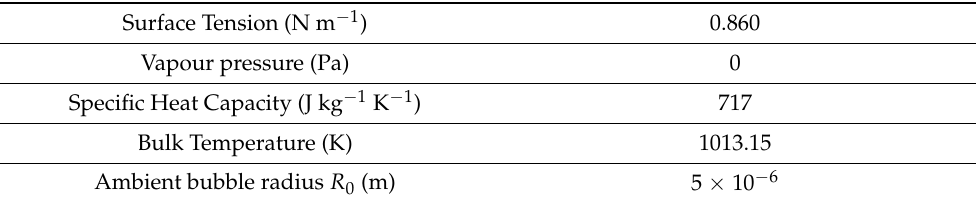
Table 3. Hydrogen bubble properties [15].